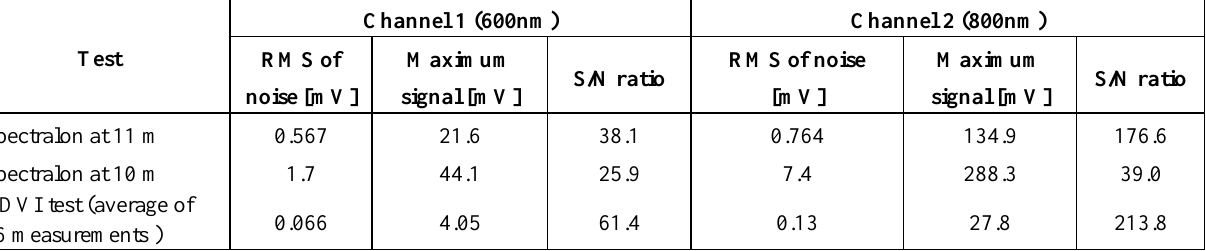
Table 1. The statistical parameters of the recording echo waveform. RMS = root mean square